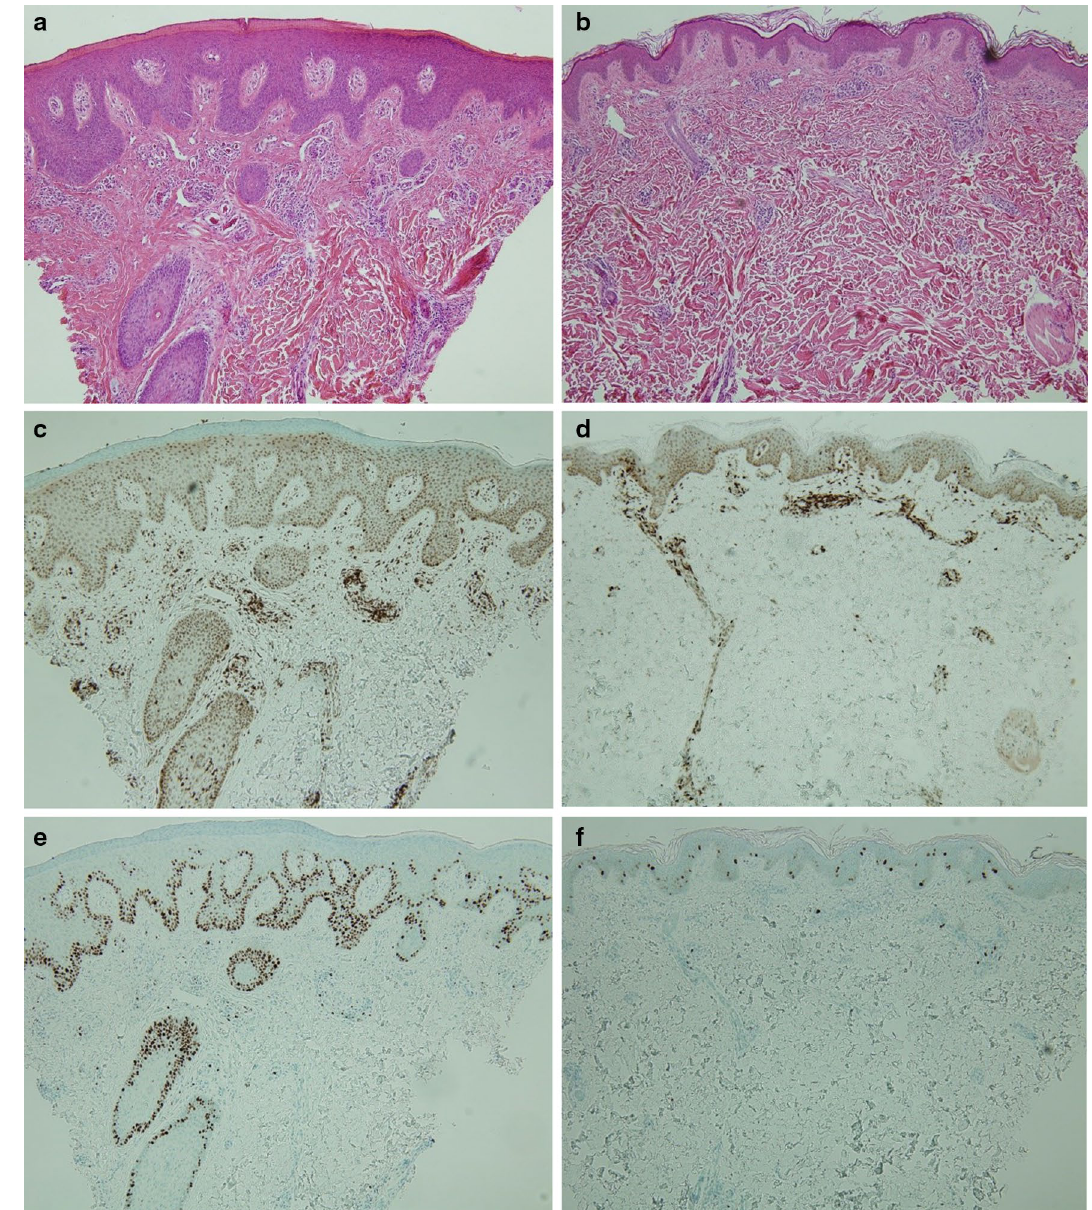
Figure 3. Skin biopsys at baseline and after 16 weeks to be compared by ( a , b ) Hematoxylin and eosin, ( c , d ) Cluster of differentiation 3 (CD3), and ( e , f ) Ki-67. After 16 weeks, the epidermal thickness, irregular acanthosis, the expression of T cells and ki-67 expression were markedly